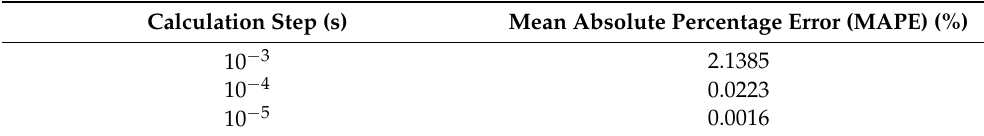
Table 2. Stiffness identification MAPE at different step sizes without